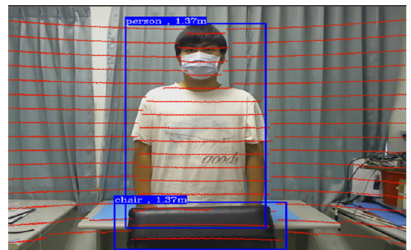
Figure 16. Measuring distance using the minimum point within the bounding box. Figure 17 uses the medium point within the bounding box to measure distance. Com-